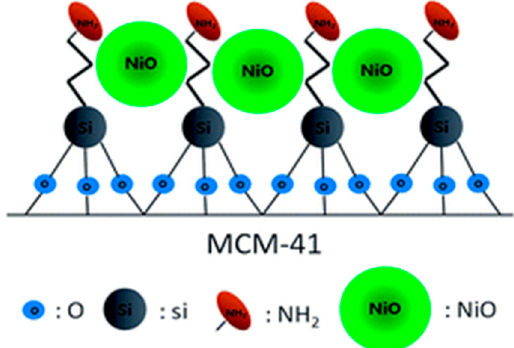
Figure 52. Schematic representation of NiO/NH 2 -MCM-41. Reproduced with permission from [92]. Copyright 2016 Royal Society of Chemistry.